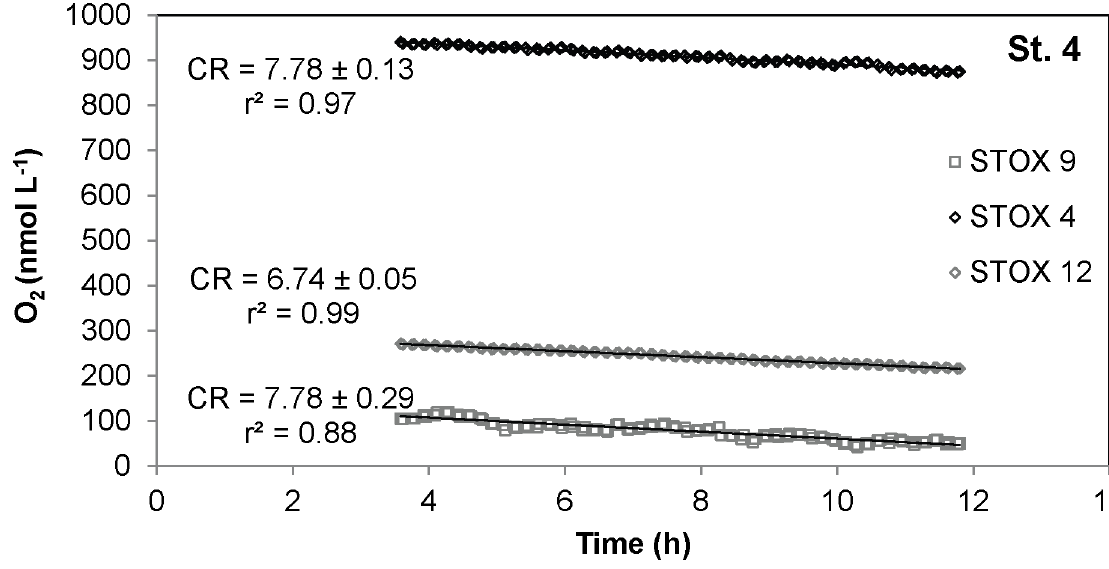
Figure 7. Time course of oxygen depletion in a STOX sensor incubation with oceanic seawater. Time course of oxygen depletion, in 3 replicate bottles, during shipboard experiments from oceanic Station 4, April 2012. The 3 samples, incubated at 3 different levels of DO, expressed similar CR rate (nmol L 2 1 h 2 1 ). CR rates 6 standard error were determined by linear regression, the first three hours of the experiment being discarded due to noise on the sensor